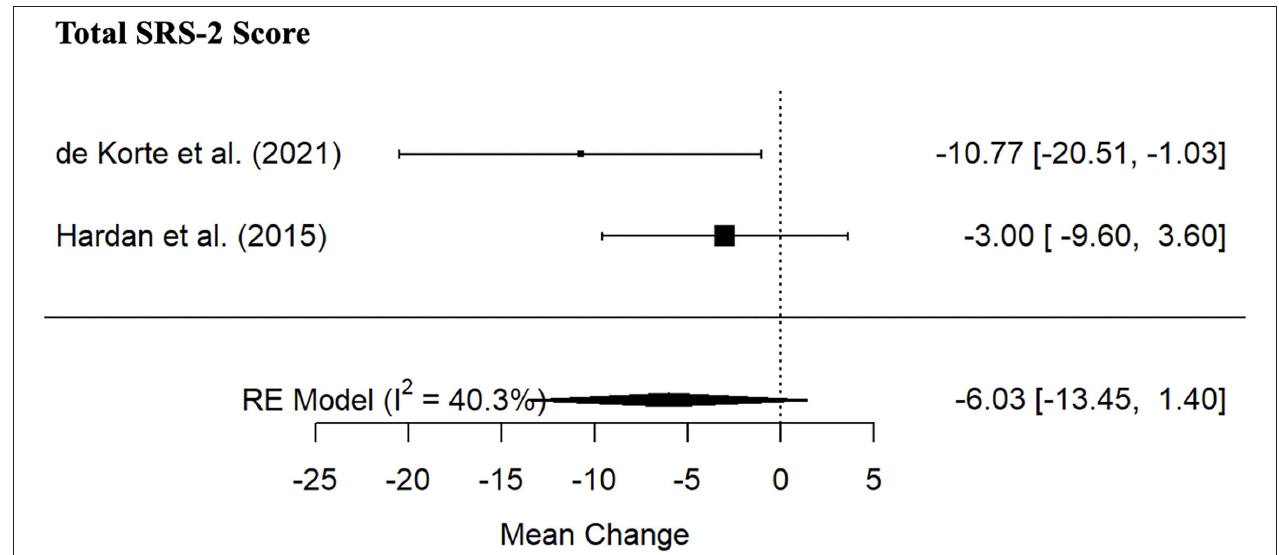
FIGURE 6 | Forest plot of estimates for PRT effects for Social Responsiveness Scale-2 Total